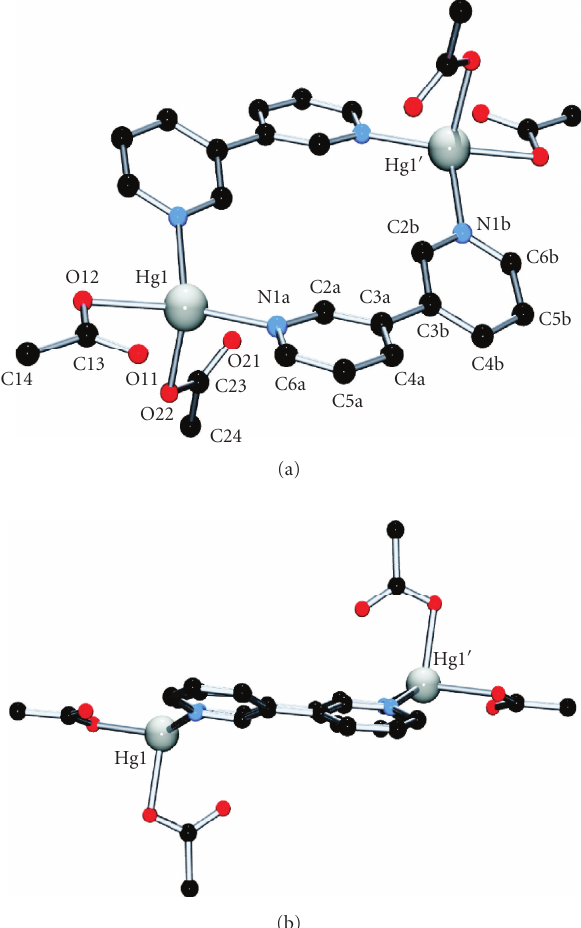
Figure 5: (a) View of 2 with atom numbering scheme. (b) Side view